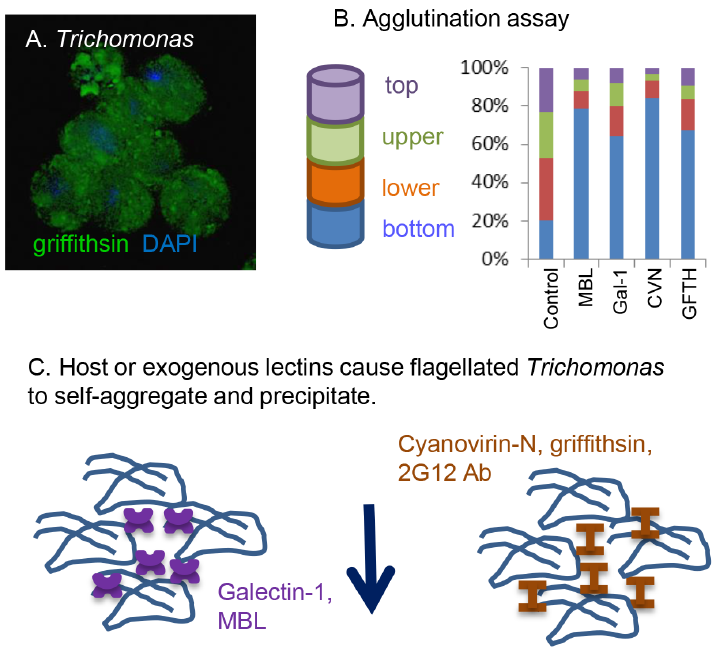
Fig 2. Host lectins (galectin-1 and MBL), as well as anti-retroviral lectins (cyanovirin-N and griffithsin) and 2G12 monoclonal antibody, agglutinate flagellated Trichomonas and cause them to precipitate. A. Fluorescence micrograph of Trichomonas aggregated by griffithsin (green). Nuclei are labeled with DAPI. B. In the absence of host or exogenous lectins added to TYM medium (control group), flagellated Trichomonas parasites swim and remain in roughly equal numbers in the top (purple), middle (green and rust), and bottom (blue) 50 μ l fractions of a 200 μ l suspension. In contrast, host MBL and galectin-1 (Gal-1), as well